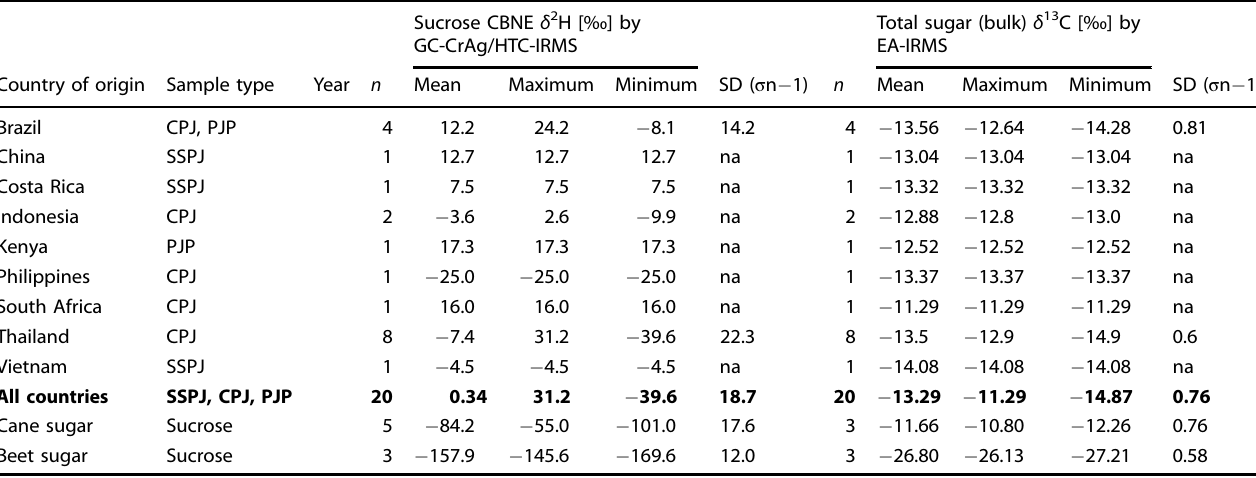
Table 1. The δ 2 H of the sucrose CBNE hydrogen and δ 13 C values of the total-sugars prepared from authentic commercial pineapple juices and from commercial samples of sugar beet and sugar cane